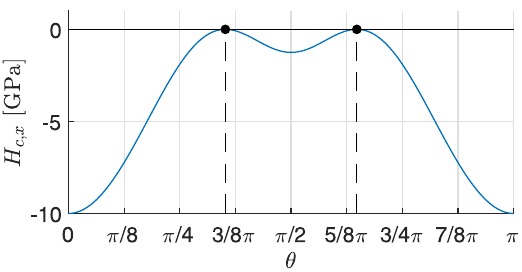
Figure 8. Difference between θ loc and φ as a function of φ for uniaxial tension